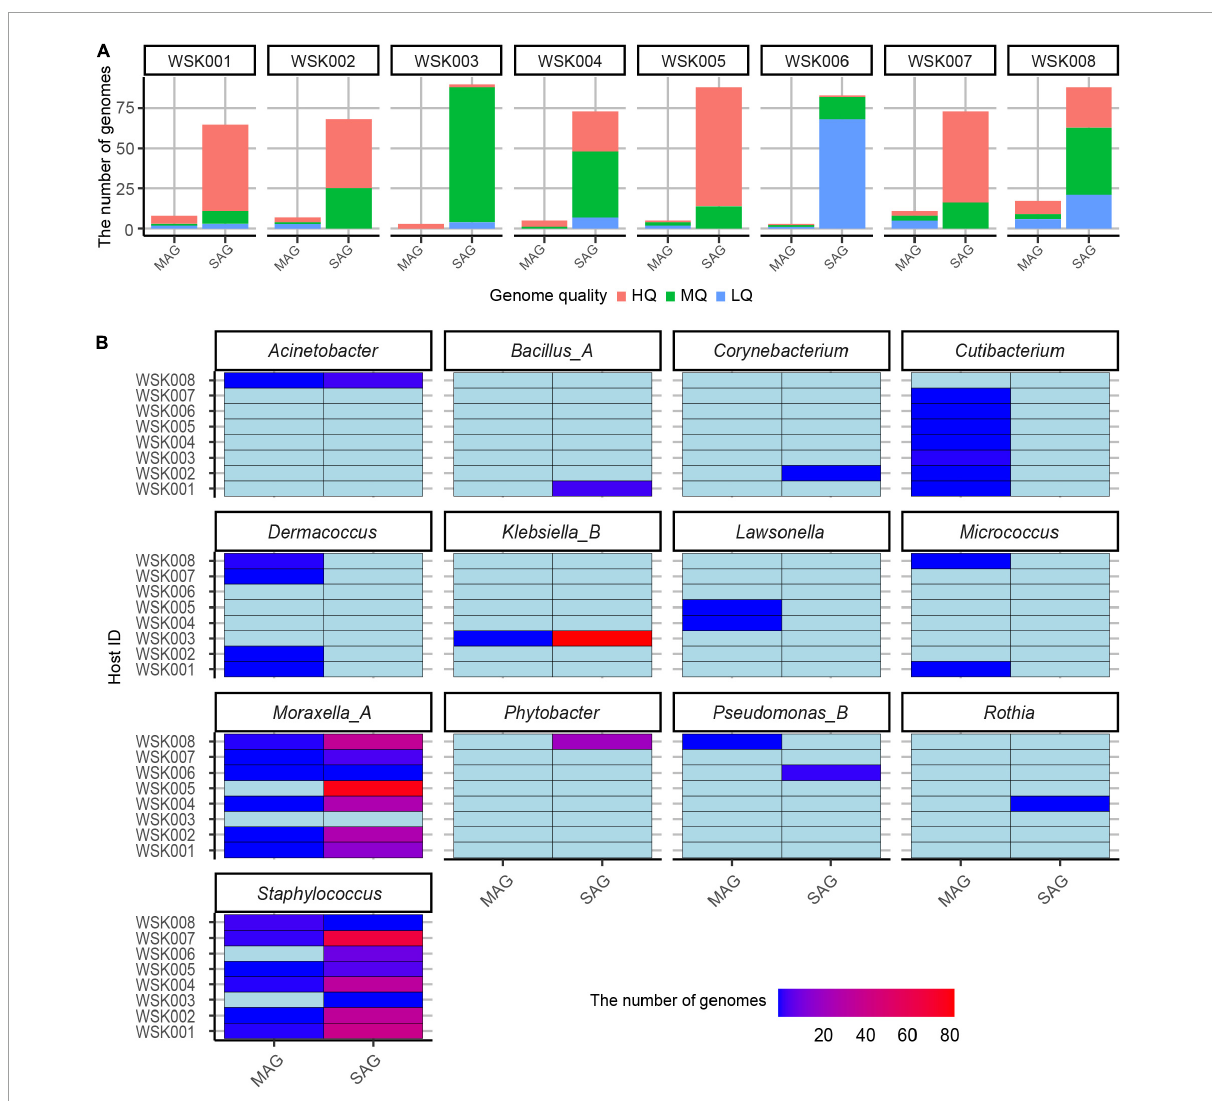
FIGURE2 Non-redundant bacterial genomes obtained from human skin bacteria. (A) The number of non-redundant single-amplified genomes (SAGs) and metagenome-assembled genomes (MAGs) for eight human hosts. Bars were colored by the genome quality (high-quality: HQ, medium-quality: MQ, low-quality: LQ, and others (high contamination rate: > 10%). (B) Genus-level classification of medium-quality SAG and MAGs for each host. The genome abundances were shown on the color scale.